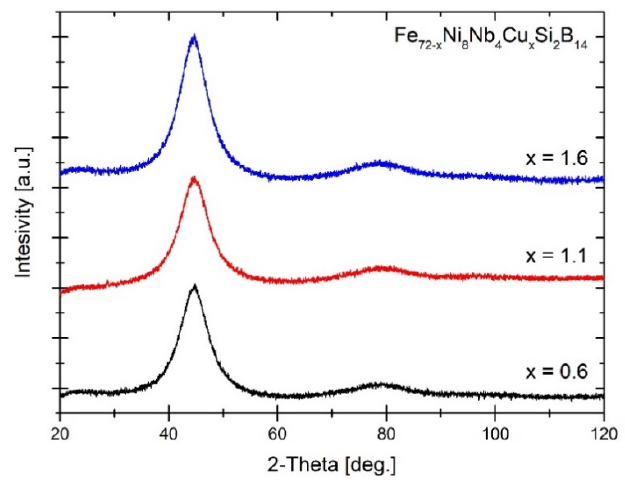
Figure 2. The XRD patterns of as-spun alloys .